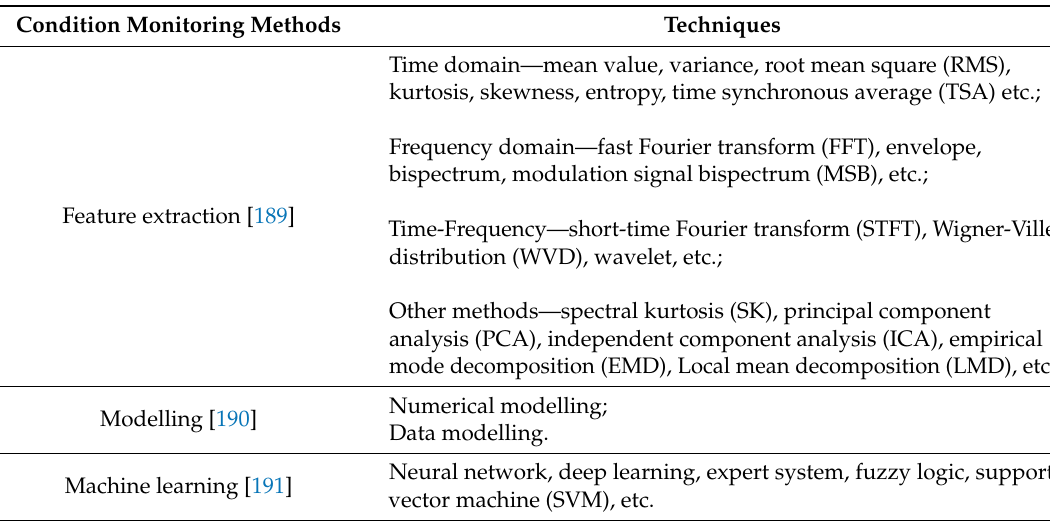
Table 8. Condition monitoring